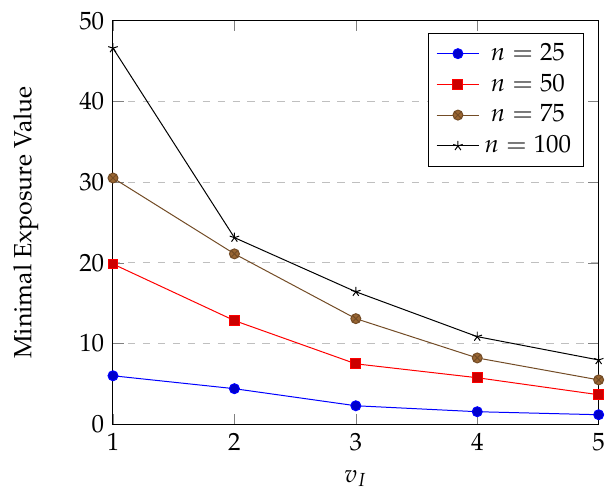
Figure 14. Effects of intruder’s speed on minimal exposure